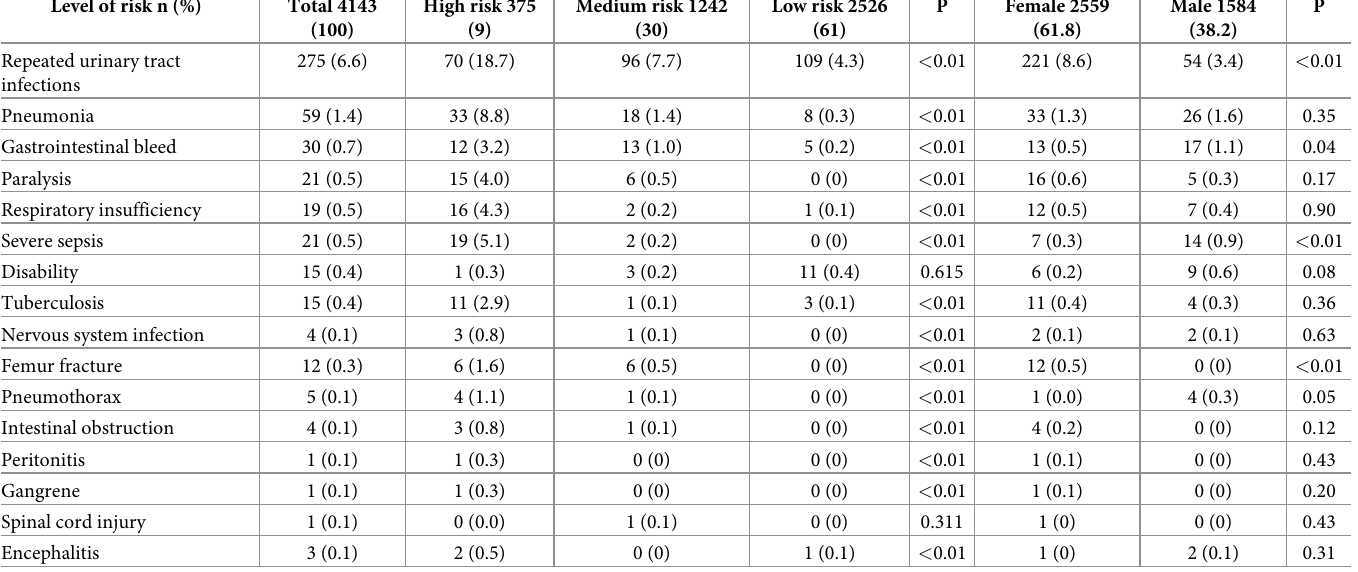
Table 3. Acute comorbidity distribution in the total population and stratified by risk level and sex. Level of risk n